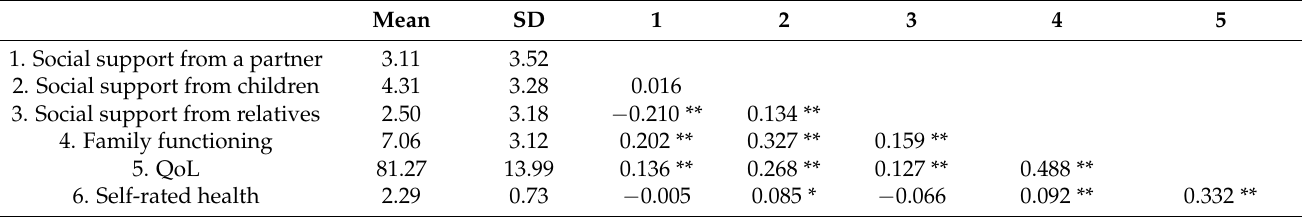
Table 2. Descriptive statistics and correlations (Pearson’s r) for the main variables of the